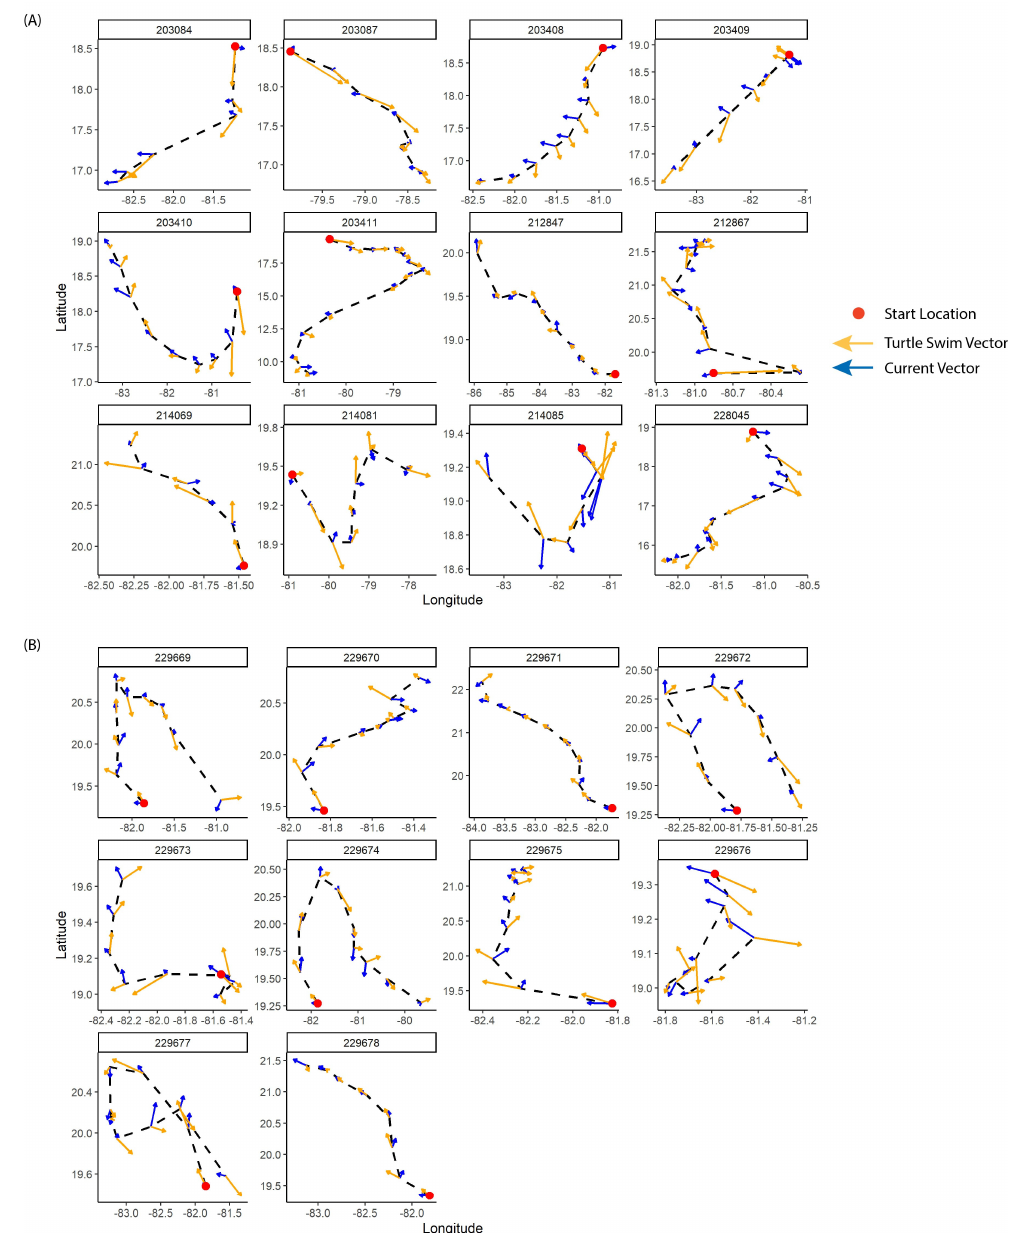
Figure 2. Plots of individual trajectories for turtles that dispersed from Grand Cayman island ( N = 22), with daily turtle swimming (yellow) and ocean current (blue) vectors overlaid for ( A ) January and ( B ) July tracking periods. Red dots indicate start locations of trajectories.